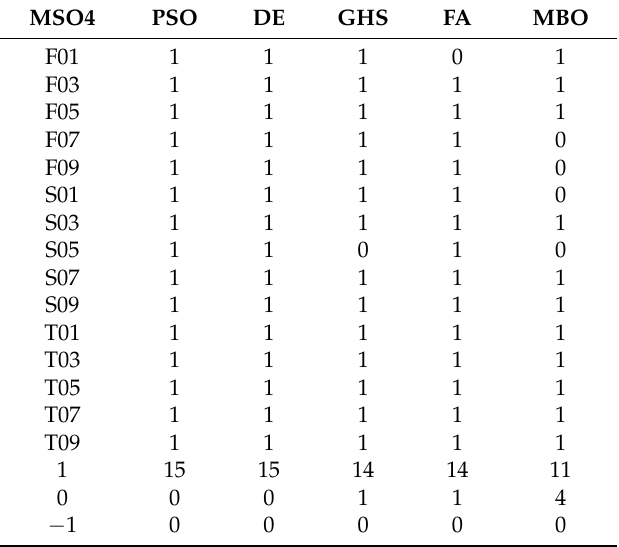
Table 9. Results of rank sum tests for MSO4 with the comparison algorithms.